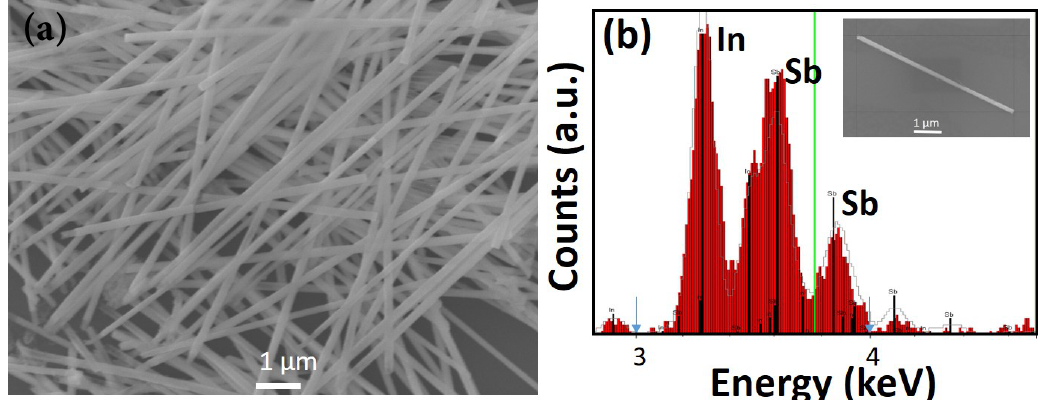
Figure 4. ( a ) SEM images of bundle of InSb nanowires after drop casting on silicon wafer; ( b ) Energy-dispersive X-ray (EDX) spectrum of a single and short ( shown in the inset of the figure ( b ).